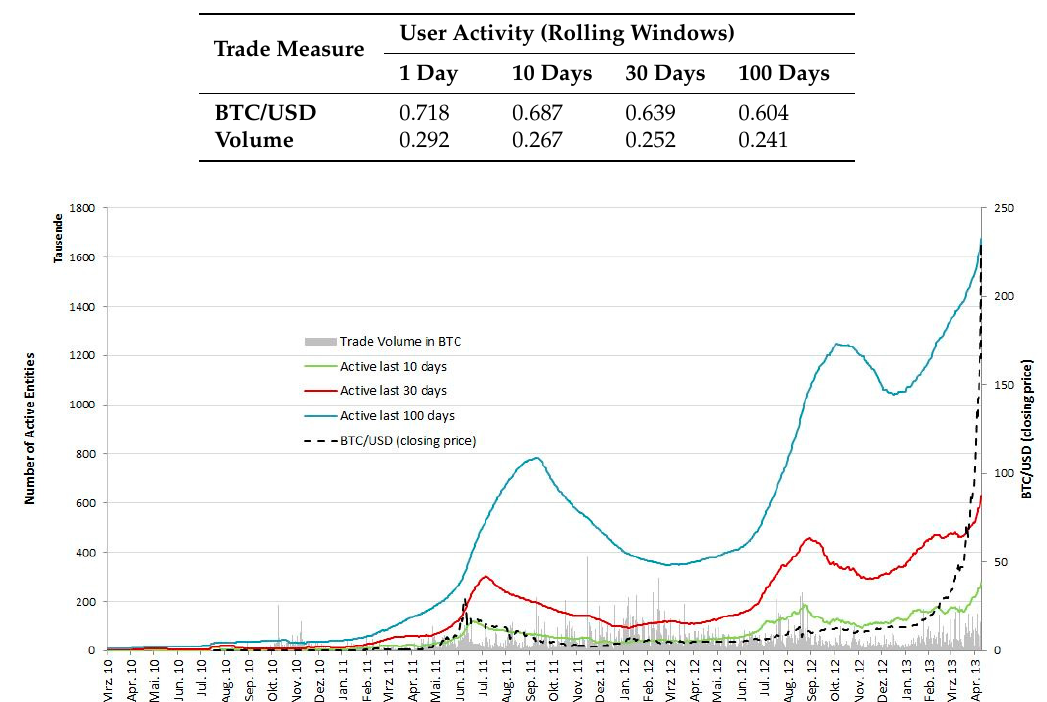
Figure 6. User Activity and Trade behavior. Table 2. Correlation Matrix (User Activity and Trade Behavior).